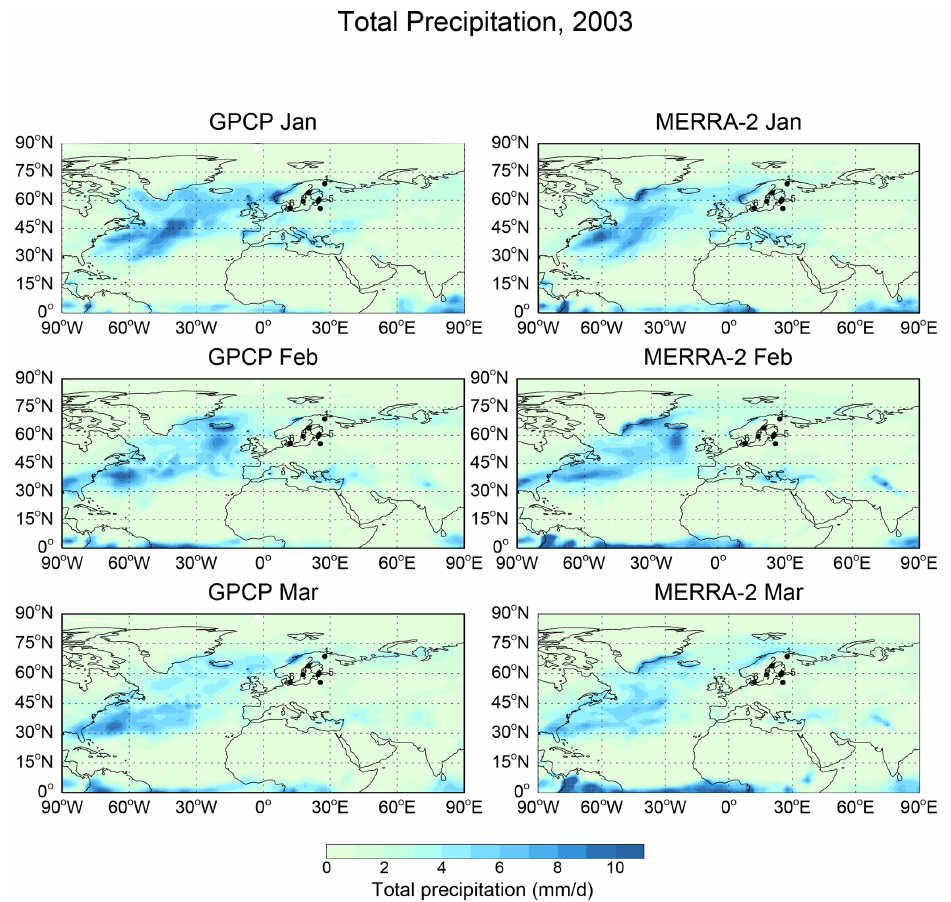
Figure 2. Comparison of the MERRA-2 total precipitation during January–March 2003 with the GPCP observations. The black dots indicate the locations of the sampling sites: 1 = Ivalo, 2 = Umeå, 3 = Helsinki, 4 = Kista, 5 = Harku, 6 =